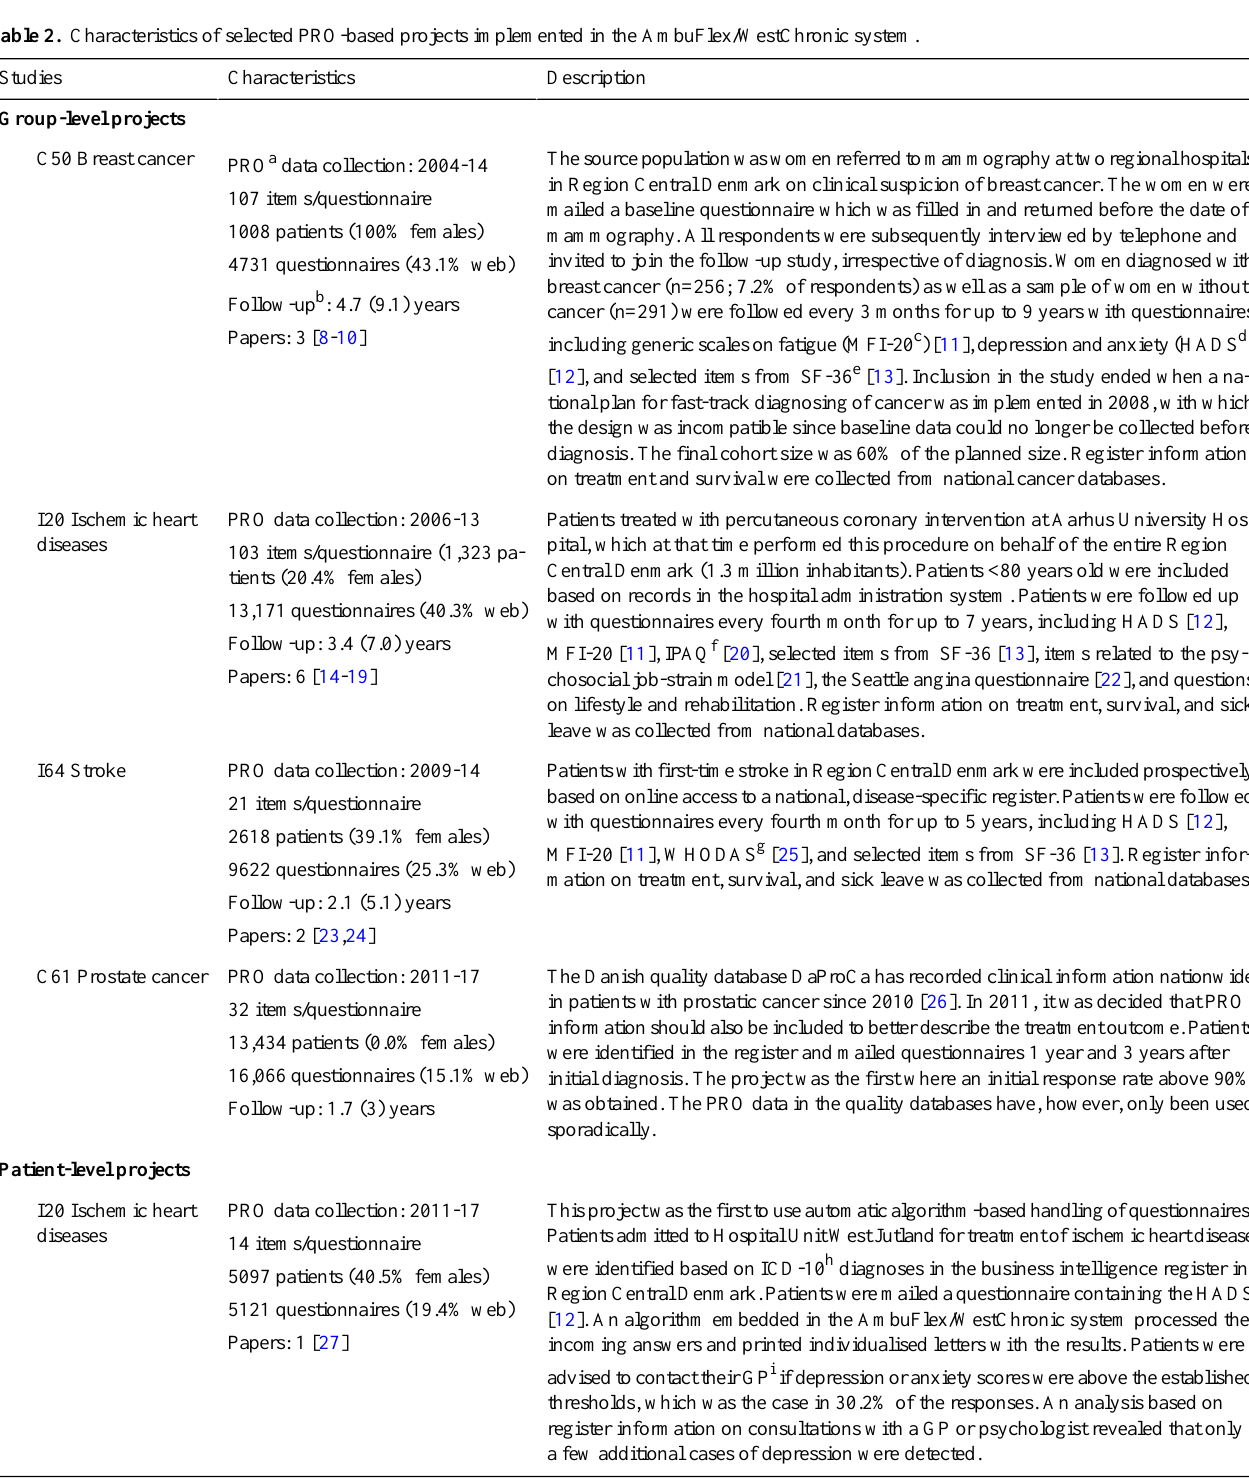
Table 2. Characteristics of selected PRO-based projects implemented in the AmbuFlex/WestChronic system.